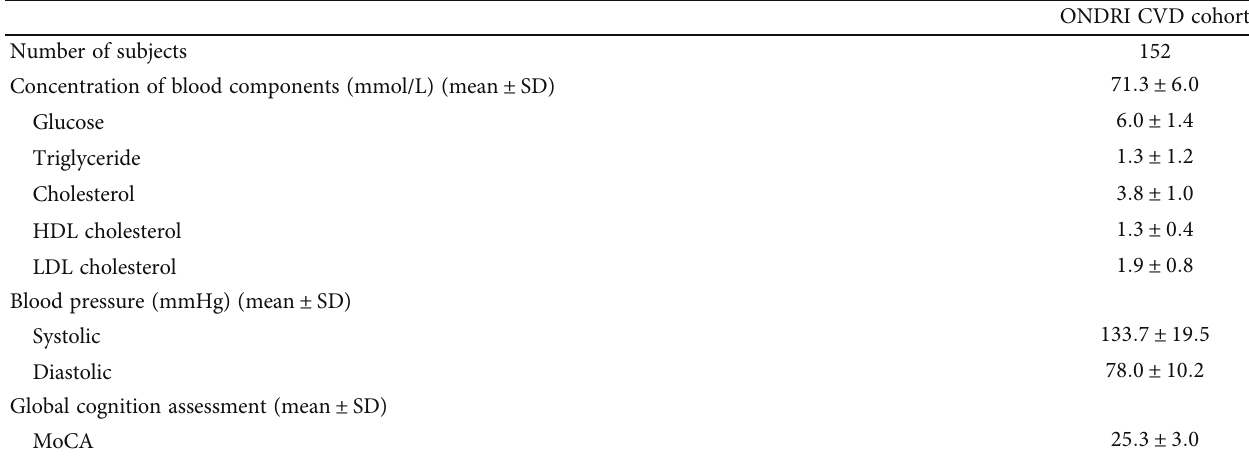
Table 1: Concentration of blood components, blood pressure, and global cognition assessments for study participants (ONDRI CVD cohort). SD =standard division and MoCA =Montreal Cognitive